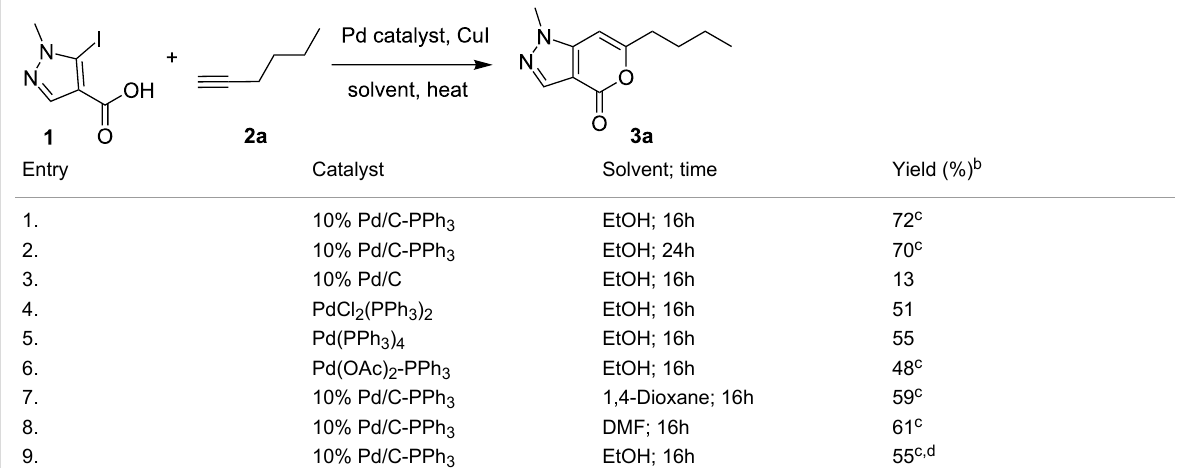
Table 1: Effect of reaction conditions on the Pd-catalyzed coupling of 5-iodo-1-methyl-1 H -pyrazole-4-carboxylic acid ( 1 ) with 1-hexyne ( 2a ). a